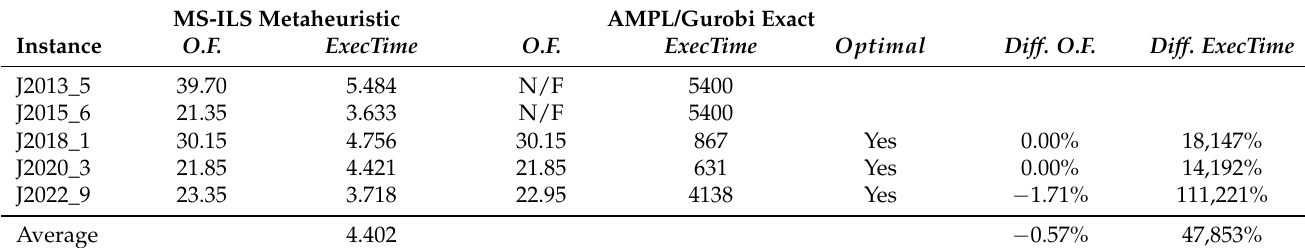
Table 10. Experiment 3 results. Performance test using instances with 20